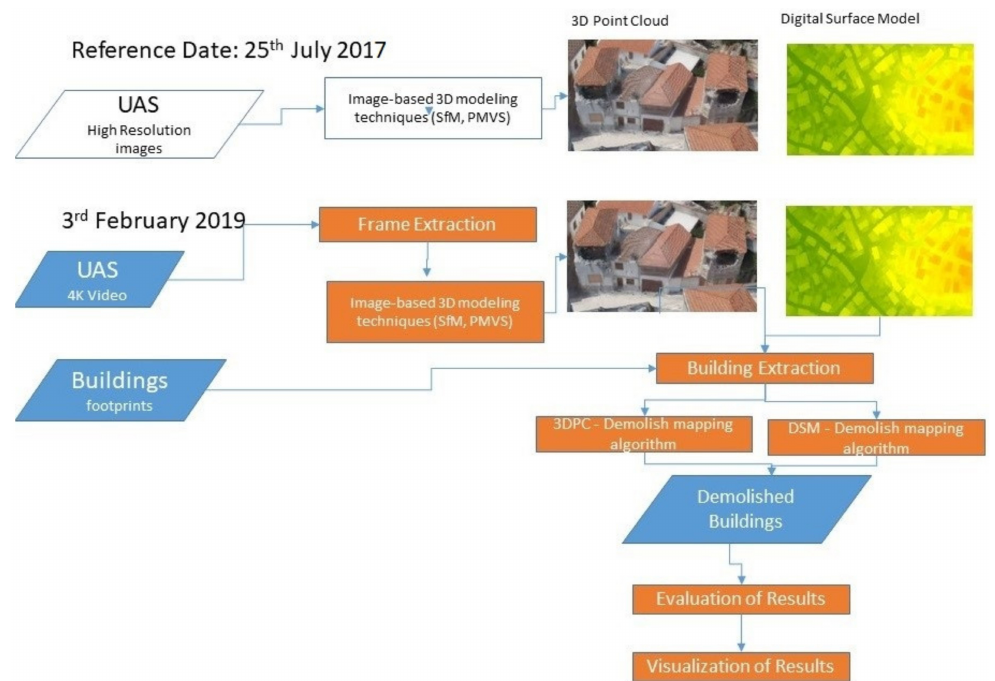
Figure 4. Flow chart of the methodology followed for 3D change monitoring and mapping of the demolition process at Vrisa settlement after the destructive